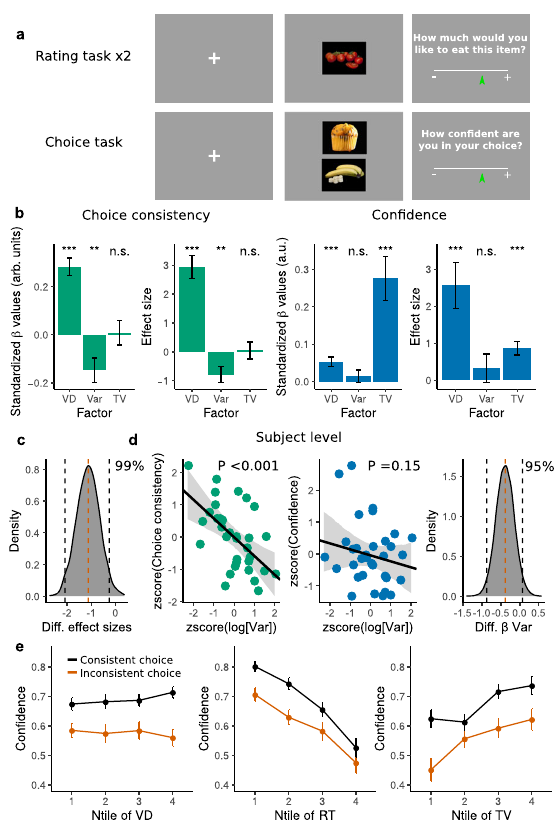
Fig. 1 Experiment and regression analysis of choice consistency and con fi dence. a Example display of the rating and choice task. Participants rated their desirability to eat the displayed food item. Next participants were asked to indicate which of the two food items they preferred to consume. After their choice, participants were asked how con fi dent they were about their decision. b Standardized estimates of a multiple logistic regression on choice consistency (green) show that higher value difference (VD) leads to more consistent choices ( β = 0.28±0.04, P <0.001). Higher variability (Var) in the rating of the two alternatives leads to less consistent choices ( β = − 0.15±0.05, P = 0.002). The total value (TV) of the two items had no reliable in fl uence on choice consistency ( β = 8.7×10 − 3 ±0.05, P = 0.43). Standardized estimates of a multiple linear regression on con fi dence reports show that higher VD lead to more con fi dence ( β = 0.05±0.01, P <0.001). Crucially, higher variability in the rating of the two alternatives does not have a reliable effect on con fi dence ( β = 0.01±0.02, P = 0.2). Higher TV increases con fi dence ( β = 0.28±0.06, P <0.001). Error bars indicate the mean standard deviation of the posterior estimates. c The difference of the effect size of the in fl uence of variability on choice consistency and con fi dence is signi fi cant with P <0.01. Vertical red dashed line indicates the median, black vertical lines indicate the 95% highest density interval. d Participant ’ s average level of variability in the rating task had a negative in fl uence on average choice consistency of that participant ( β = − 0.58±0.16, P <0.001, r = − 0.53), however, this effect is not present for the same analyses performed on con fi dence reports ( β = − 0.19±0.18, P = 0.15, r = − 0.22), P -values are based on the highest density interval of the posterior estimates. Gray shaded areas indicate the 95% con fi dence bands. The difference of the effect of average variability on choice consistency and con fi dence ratings is signi fi cant ( Δ β cons − conf = − 0.39±0.24, P = 0.05). e Con fi dence as a function of absolute value difference shows the qualitative signatures of con fi dence reports guided by its statistical de fi nition. Con fi dence as a function reaction time shows signatures reported in previous work. Con fi dence as a function of total value con fi rms the quantitative results presented in panel ( b ). Data are presented as mean values±SEM. For the whole fi gure n = 33 independent participants. Source data are provided as a Source Data fi